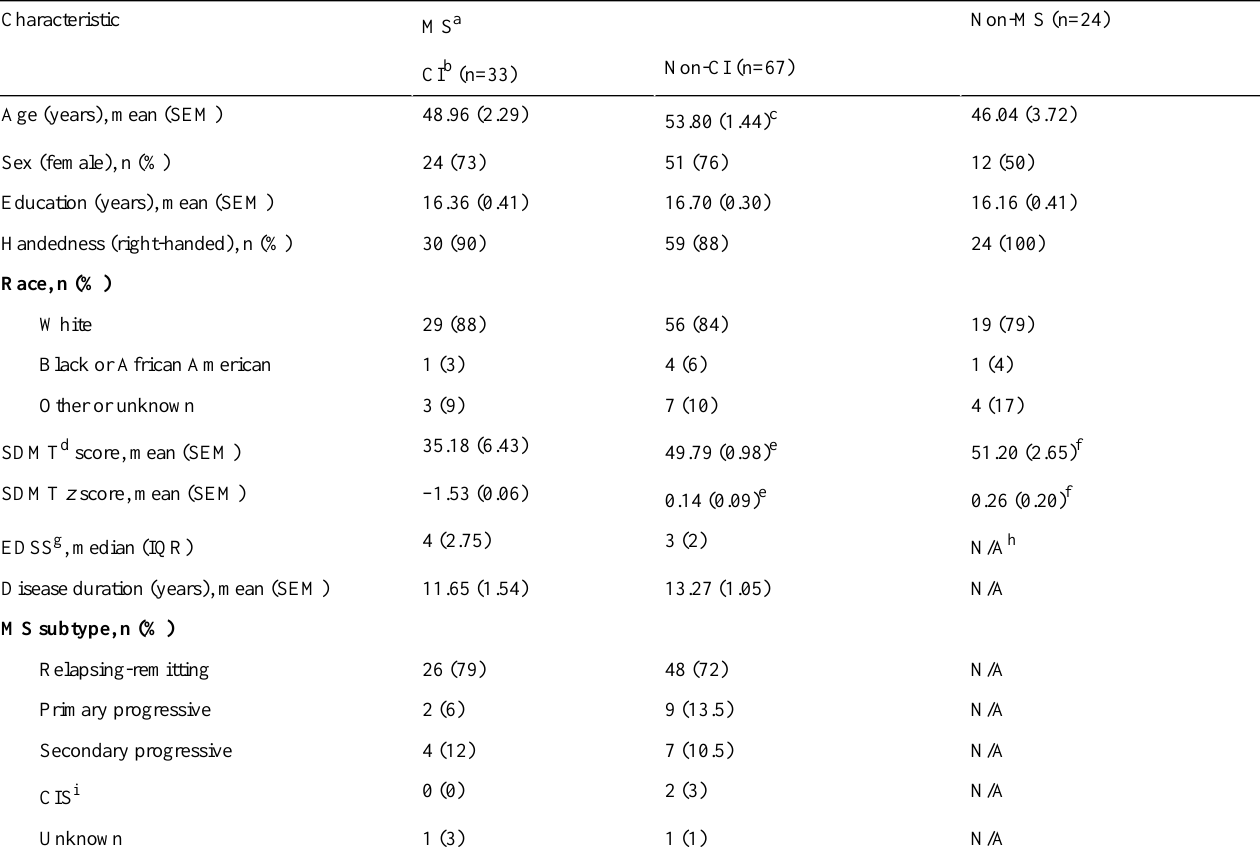
Table 1. Demographic and clinical characteristics of participants.